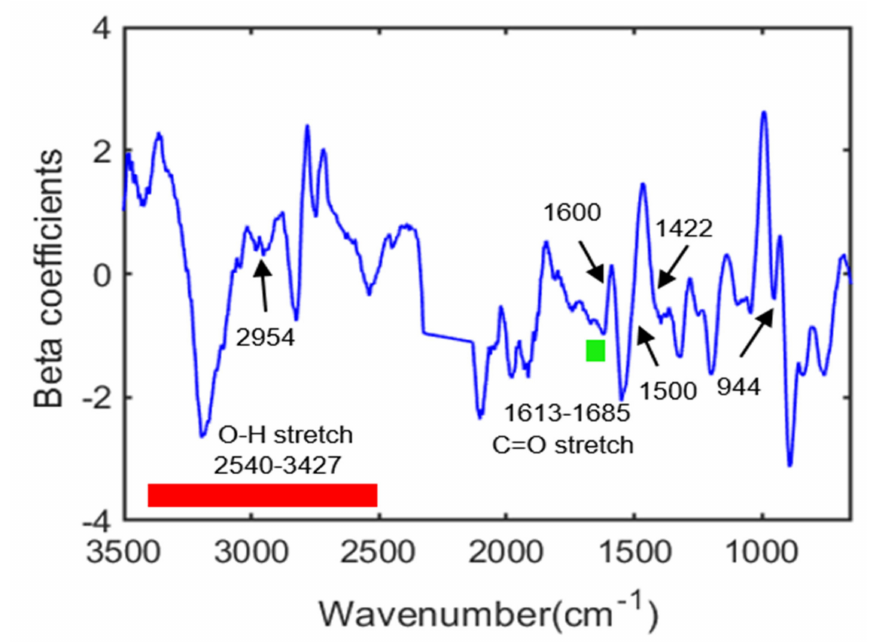
Figure 7. Beta coefficient plot for PLSR model in predicting the total phenolic content in moringa powder